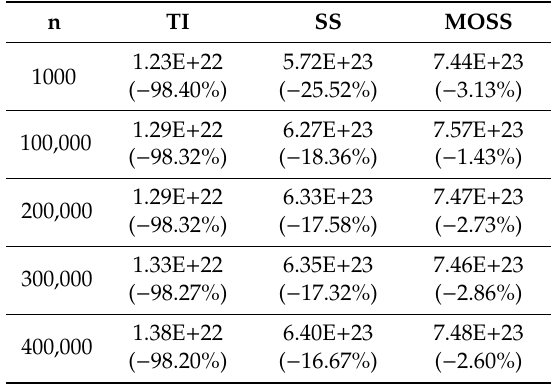
Table 6. BME (BME Relative Error [%]) for ADE2 model using thermodynamic integration (TI), steppingstone sampling (SS), and multiple one-steppingstone sampling (MOSS), for K = 5 with a varying n number of samples per K interval. The reference BME solution is 7.68 × 10 23 ± 7.34 × 10 21 , and the 95% credible interval of the reference solution error is ± 1.57%. n TI SS 1.23E + 1000